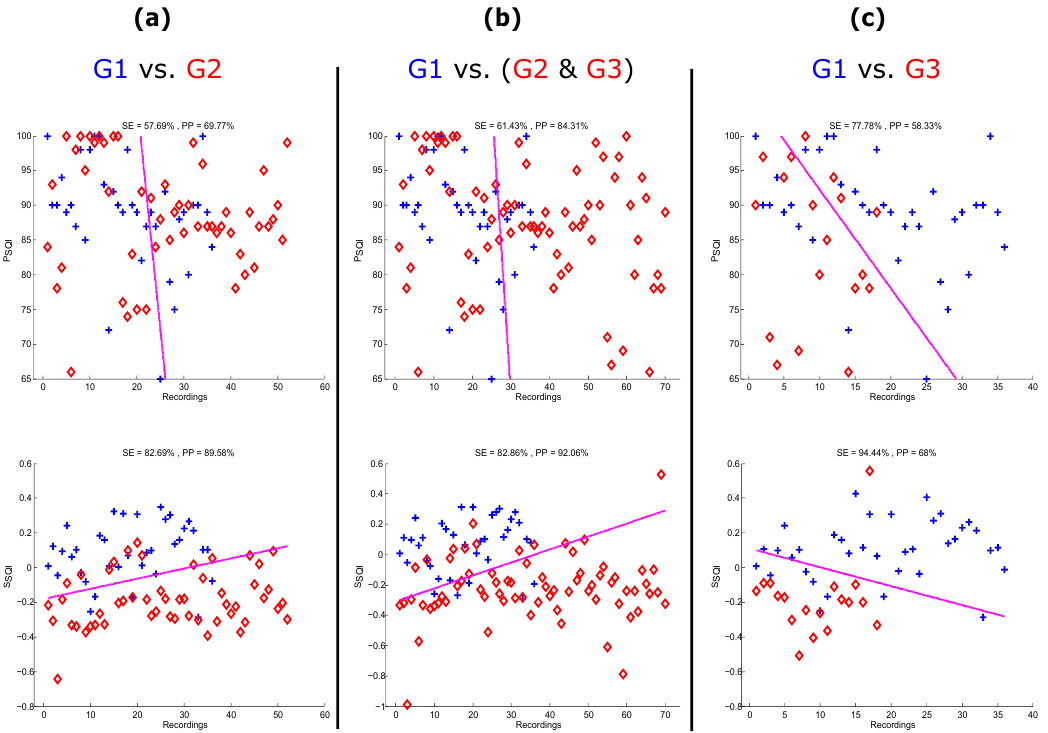
Figure 4. Linear classification of the gold standard signal quality index (perfusion index [P SQI ]) and the skewness index (S SQI ) based on the adjudicated photoplethysmograms. ( a ) excellent PPG signal quality (G1) versus acceptable PPG signal quality (G2); ( b ) G1 versus (G2 and unfit to diagnose PPG signals (G3)); and ( c ) G1 versus G3. The plus signs refer to the G1 recordings, while the diamond symbols refer to the (G2 & G3) or G3 recordings. SE stands for sensitivity, and PP stands for positive